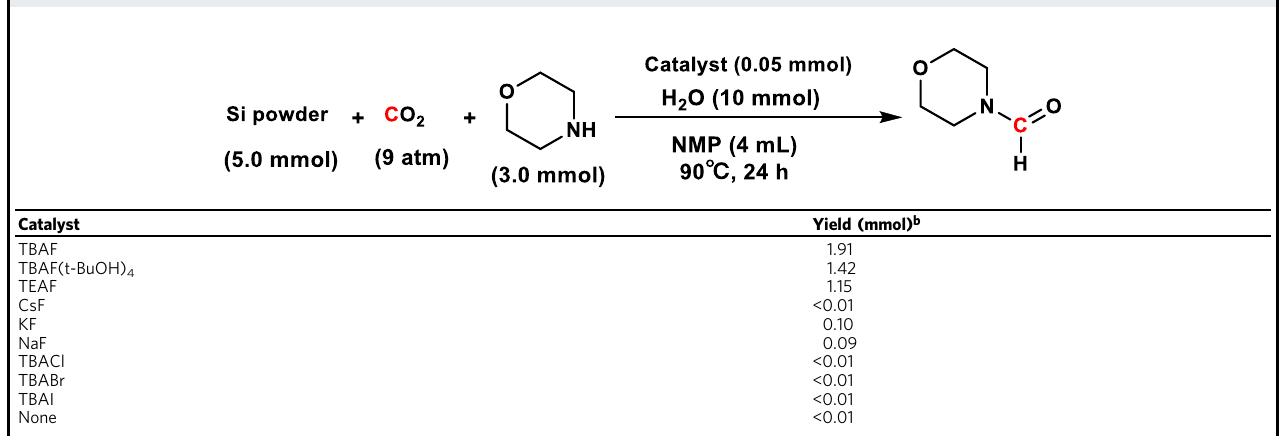
Table 1 CO 2 conversion to formamide with various fl uoride catalyst a .